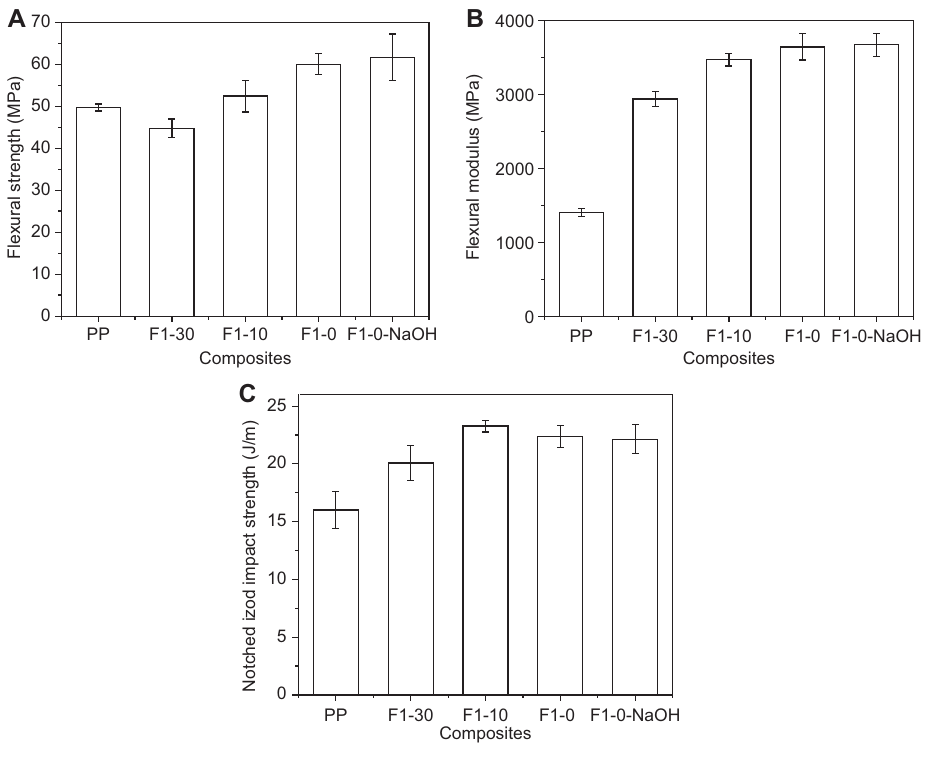
Figure 4 Flexural strength (A), fl exural modulus (B) and notched izod impact strength (C) of fl ax/PP composites as a function of